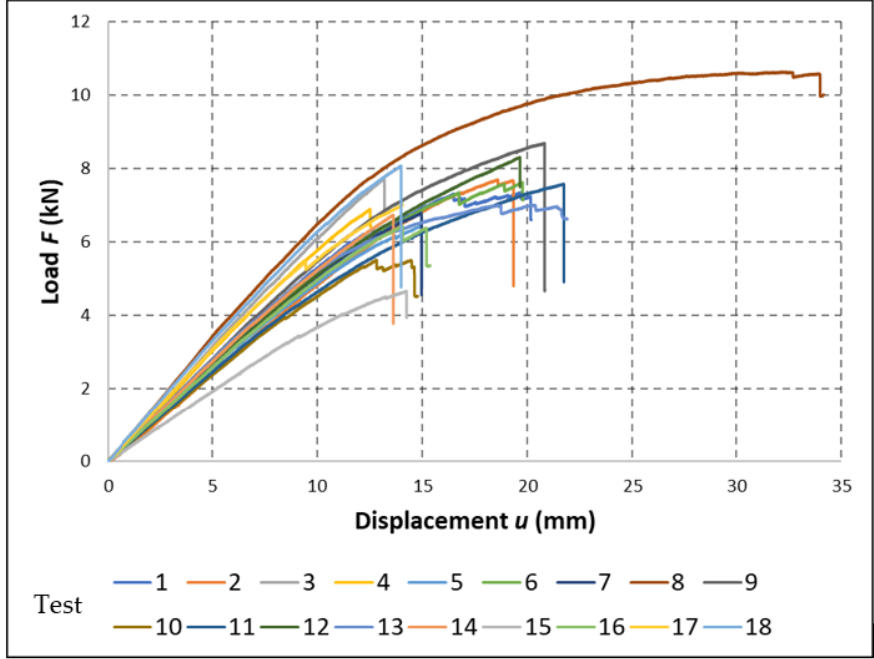
Figure 3. Load–displacement diagrams of individual specimens of the four-point flexural test.